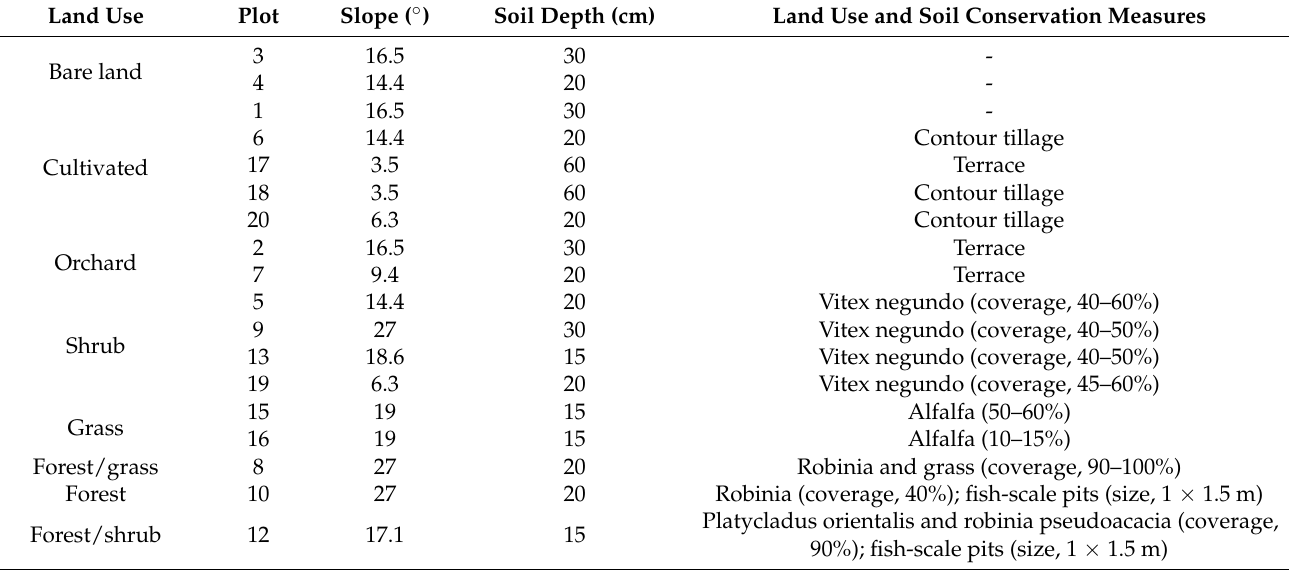
Table 1. Information of the selected 18 runoff plots in the study